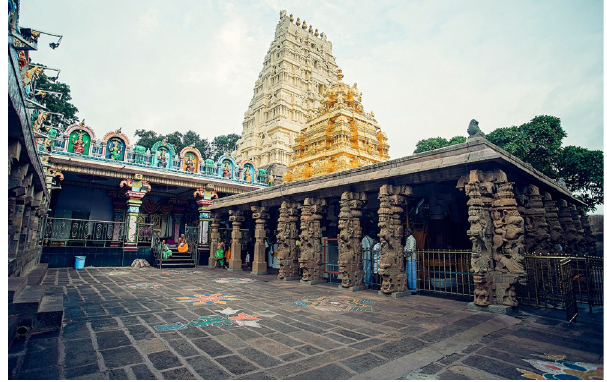
Figure 4 Srisailam Temple (Srisailam Devasthanam, 2016)